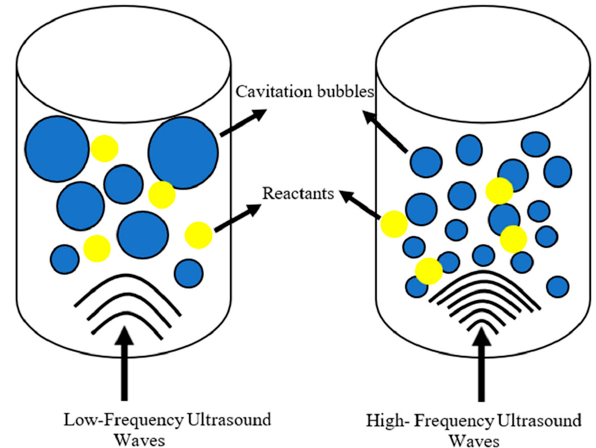
Figure 4. Di ff erences between the amount of cavitation bubbles between LFU and